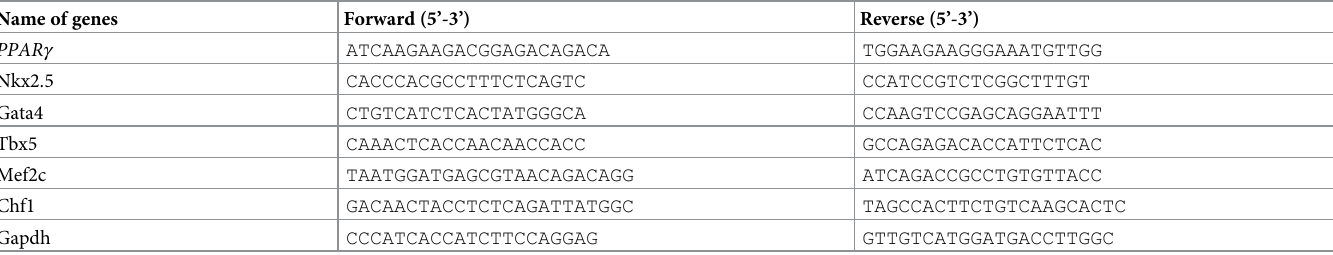
Table 1. Primer sequences used for real-time quantitative